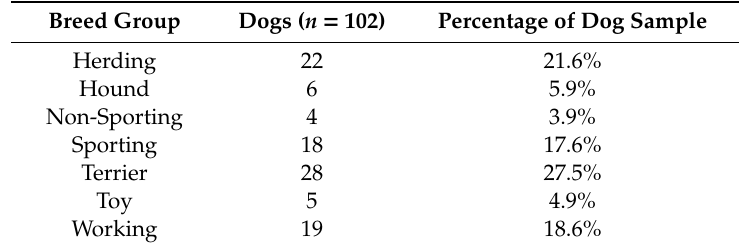
Table 3. Dog breed group by number of animals and percentage of the sample ( n = 102).